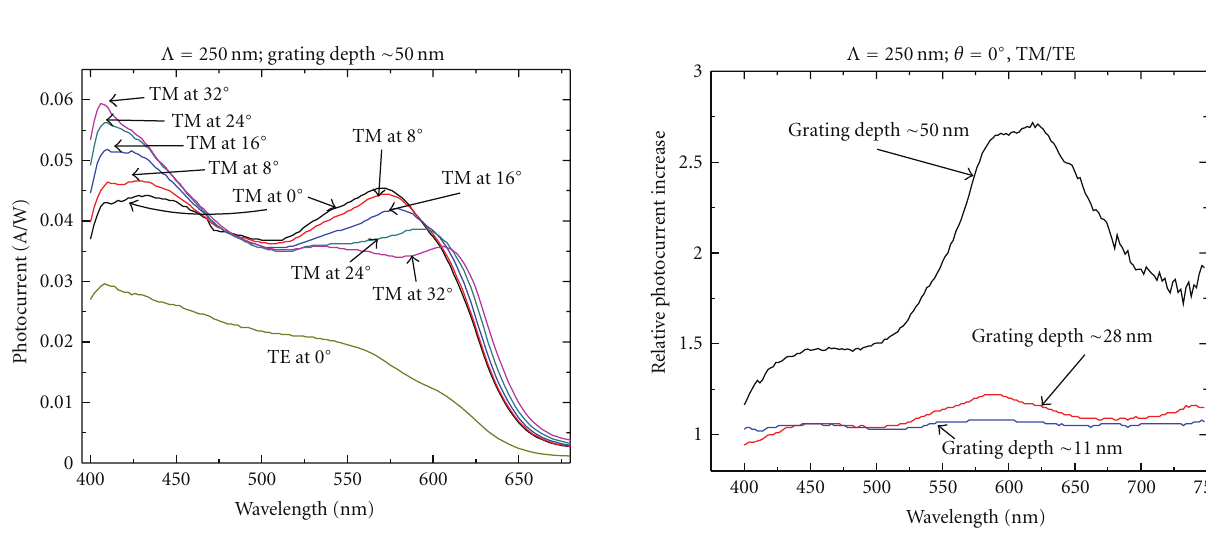
Figure 6: The TE and TM photocurrent responses of the P3HT- PCBM layer as a function of wavelength with Λ = 325nm and at normal incidence.